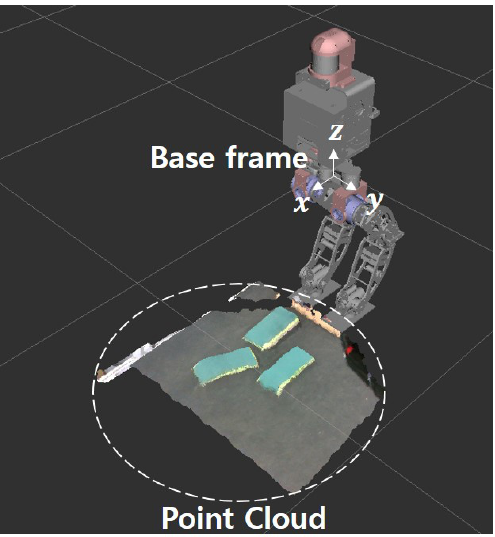
Figure 2. Point cloud with coordinates transformed based on the base